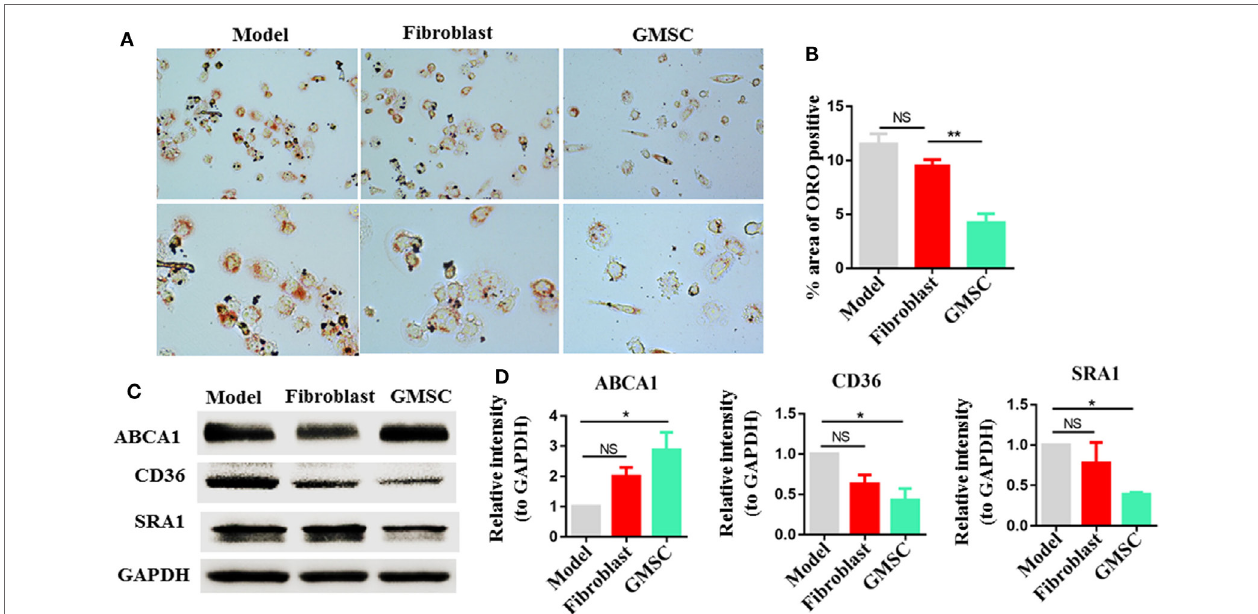
FigUre 4 | Effect of human gingiva-derived mesenchymal stem cells (GMSC) on the formation of macrophage foam cells. Macrophages were cultured in two conditions: model, macrophages were cultured in the presence of oxidized LDL (OX-LDL) for 48 h; fibroblast or GMSC, macrophages were co-cultured with GMSC or fibroblast in the presence of OX-LDL for 48 h. (a,B) Macrophages were stained with Oil Red O, representative photos from each group are depicted and the bar graphs show the mean ± SEM, n = 4. (c,D) Macrophages were subjected to Western blotting to determine the protein level of CD36, scavenger receptor A1 (SRA1), and ATP-binding cassette transporter A1 (ABCA1) and the bar graphs show the protein band intensity of ABCA1, CD36, and SRA1 normalized to GAPDH. Data are the representative of three independent experiments and presented as mean ± SEM. * p < 0.05; ** p < 0.01; NS, p >